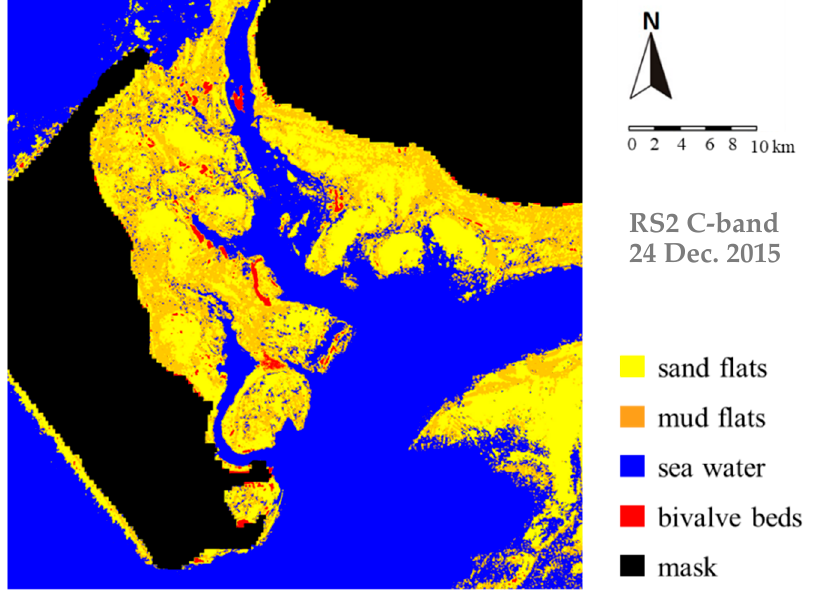
Figure 6. Same as Figure 5, but for RS2 C-band quad-pol SAR data acquired on 24 December 2015 at 05:43 UTC, 18 min after the low tide.